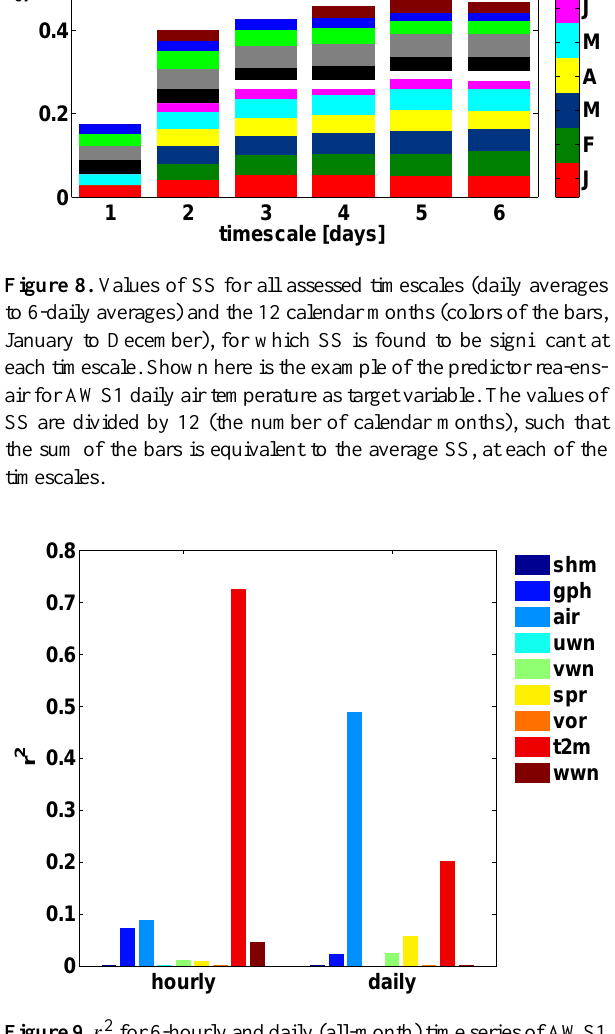
Figure 9. r 2 for 6-hourly and daily (all-month) time series of AWS1 air temperature and all predictors assessed in Sect.